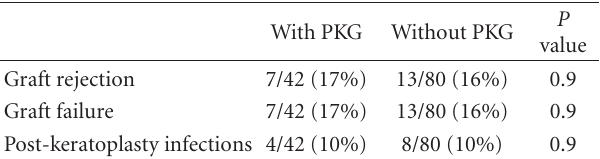
Table 7: Incidence of graft rejection, graft failure, and post- keratoplasty infections in cases with post-keratoplasty glaucoma (PKG) versus in cases without PKG. With